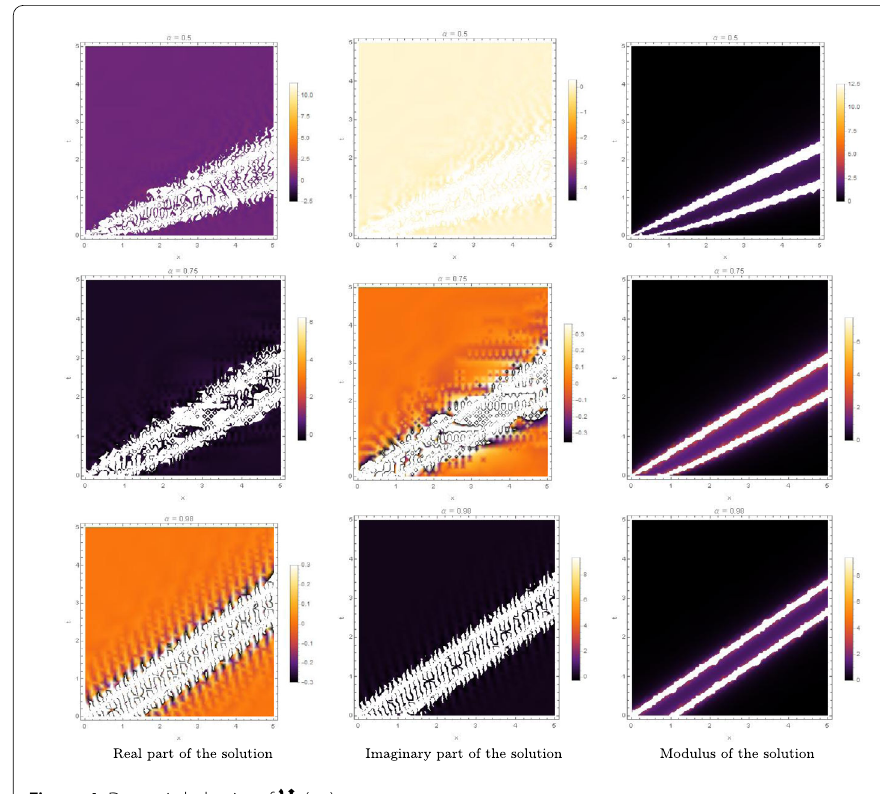
Figure 4 Dynamic behavior of U 9 ( x , t )